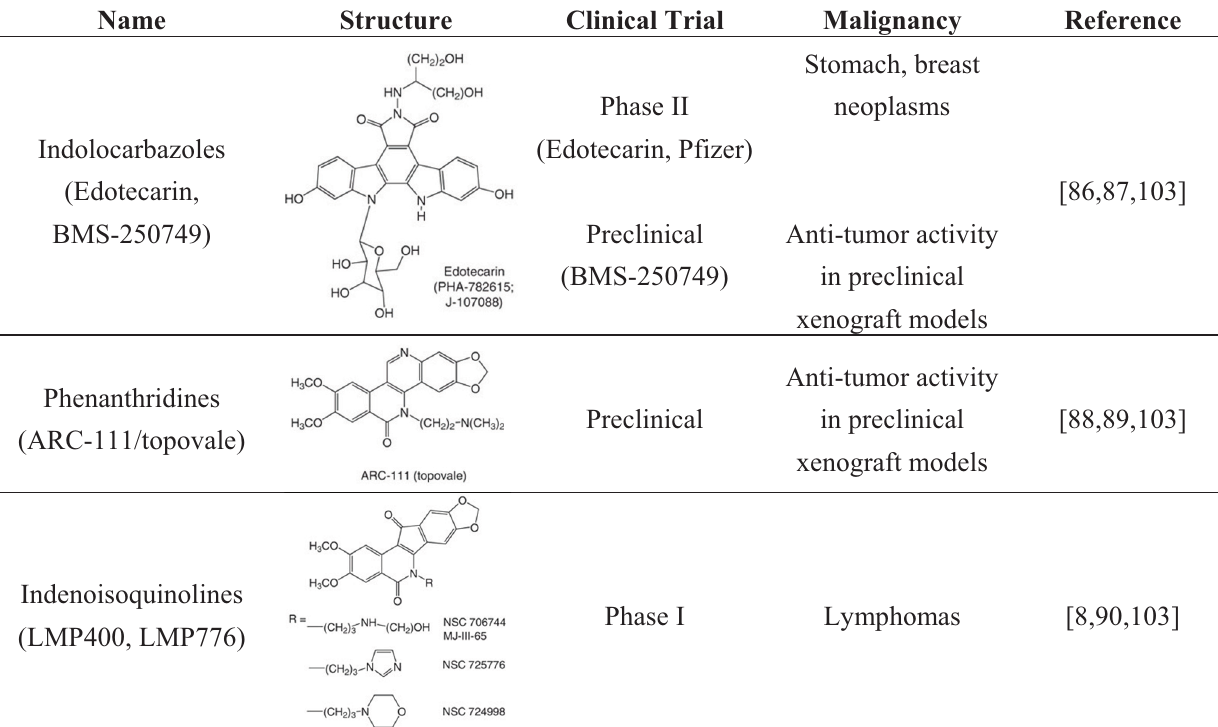
Table 2. Non-CPT derivatives in preclinical and clinical trials